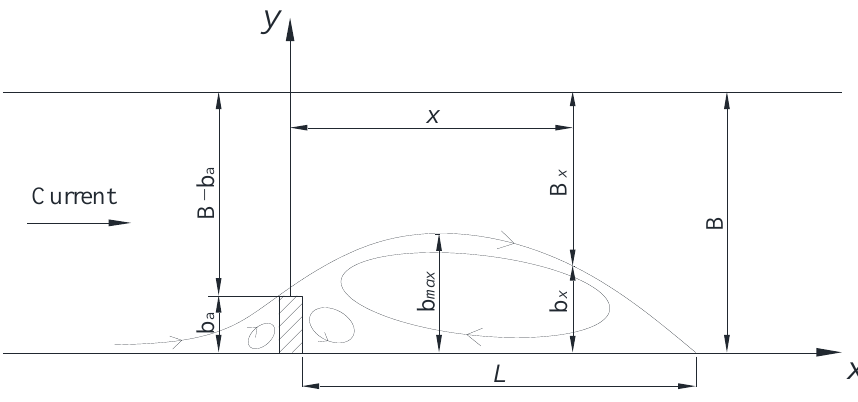
Figure 18. Schematic diagram of the recirculation zone behind a single groin.